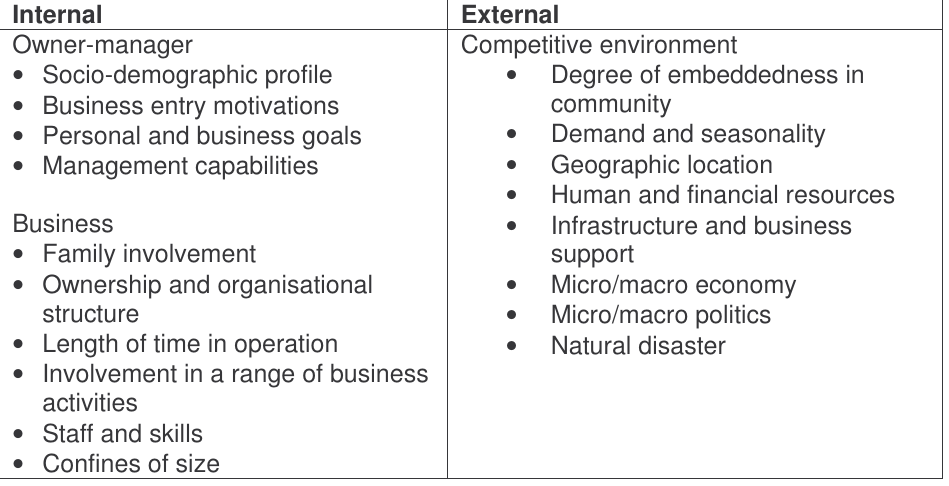
Source : Morrison and Teixeira,